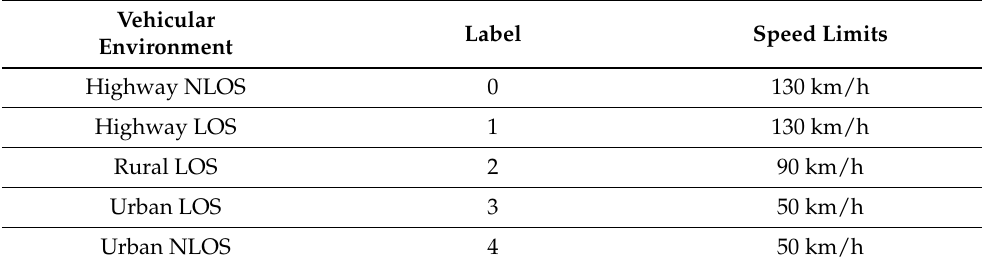
Table 2. Vehicular environment labels and required speed